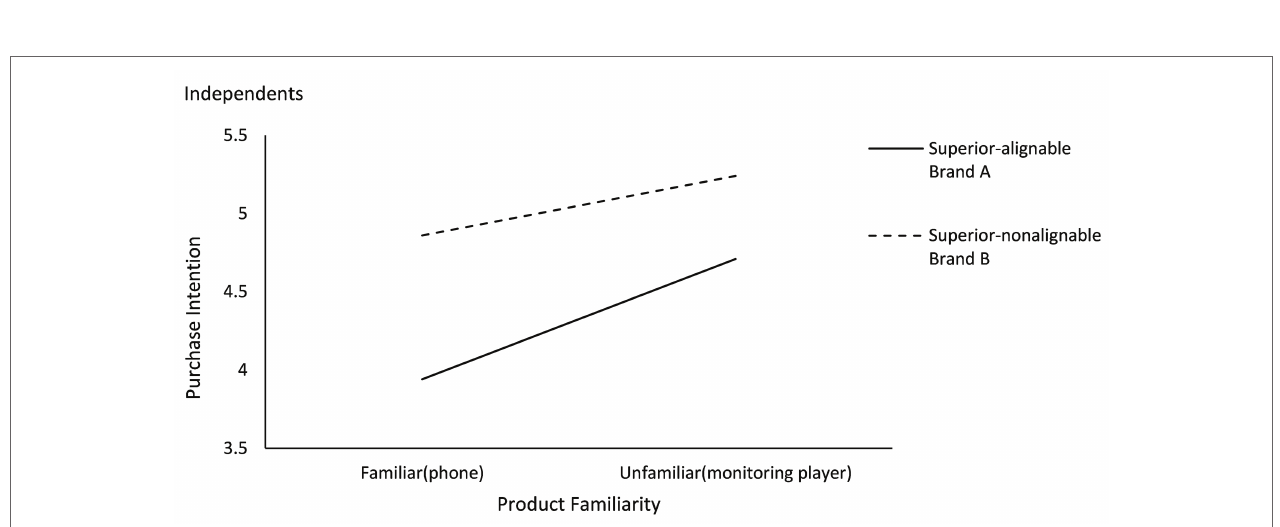
FIGURE 5 | Effects of product familiarity and attribute alignability on purchase intention for independents (study